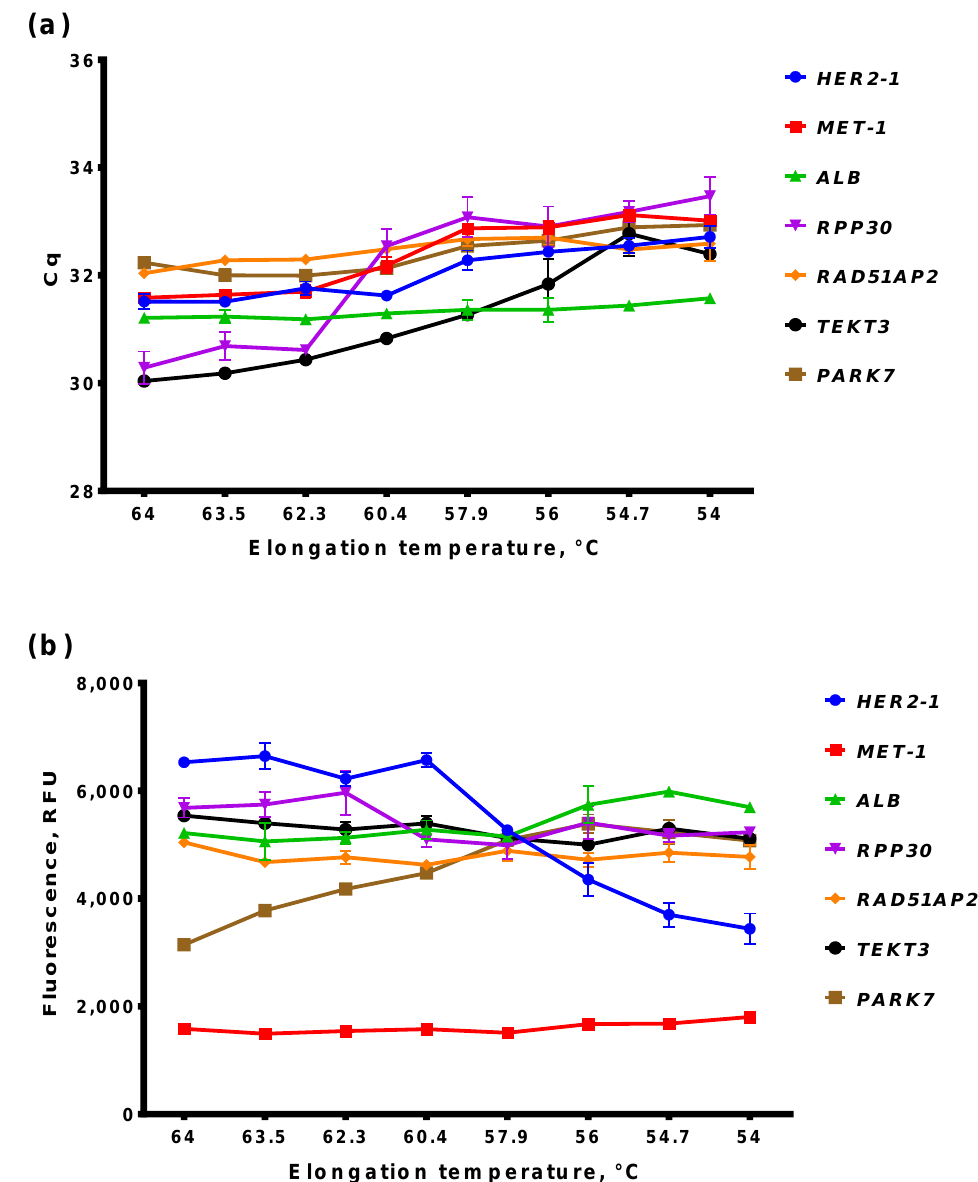
Figure 1. Results of qPCR with monoplexes. ( a ) Cq values; ( b ) end-point fluorescence after baseline subtraction. X-axis marks elongation temperature, Y-axis marks Cq values ( a ), or end-point fluorescence ( b ). Whiskers designate standard deviation in two experiments.